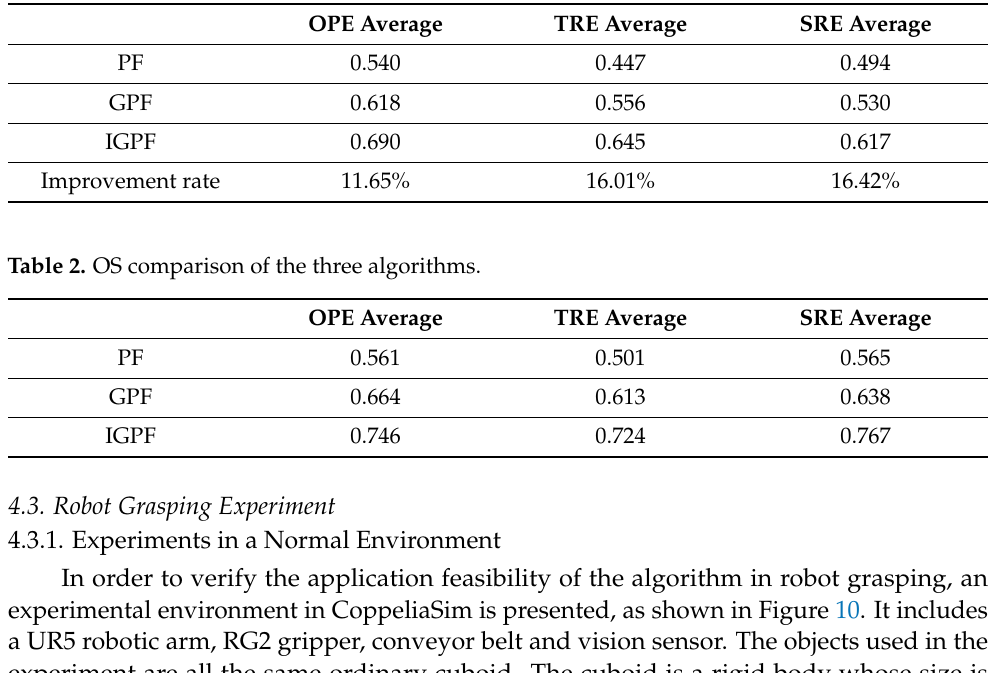
Table 1. Initial parameter setting of algorithm.